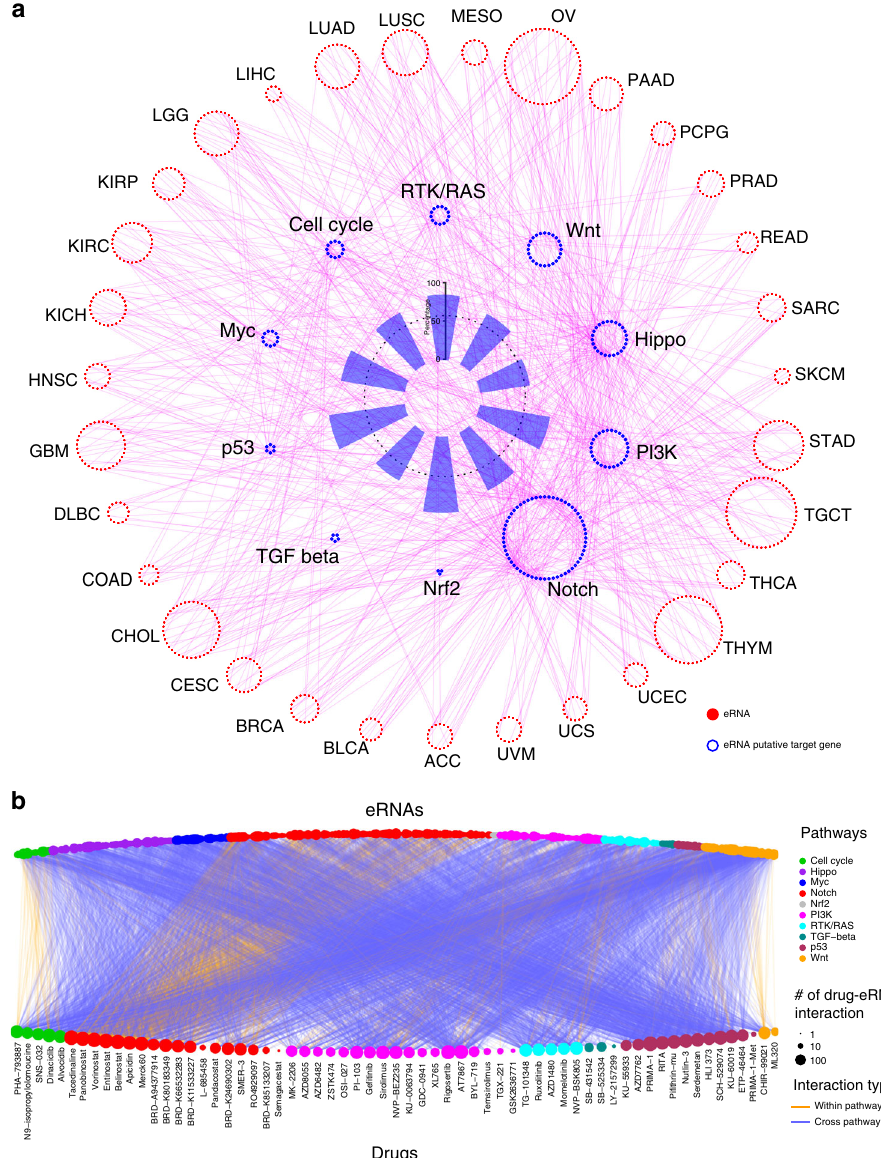
Fig. 3 Putatively regulatory network and drug response of eRNAs on signaling pathways. a eRNA and putative target gene in 10 cancer signaling pathways. Red nodes in outer circle denote eRNAs that regulate genes in cancer signaling pathways across cancer types. Blue nodes in middle circle denote putative target gene across cancer signaling pathways. Blue bars in inner circle denote percentage of eRNA putative target genes across each pathway. Magenta links denote correlation between eRNAs and their putative target genes. b Association between eRNAs (top) and drugs (bottom) across different cancer signaling pathways. Orange and blue links, respectively, denote within- and cross-pathway